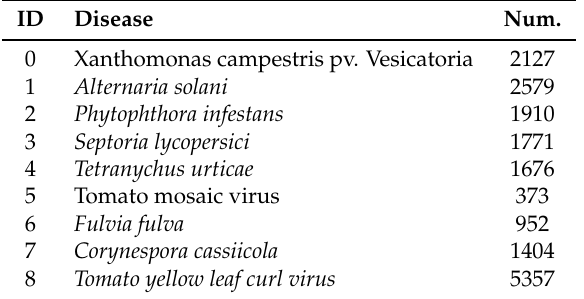
Table 1. The number of images of each tomato disease in Plant Village dataset [27]. ID Disease Num.